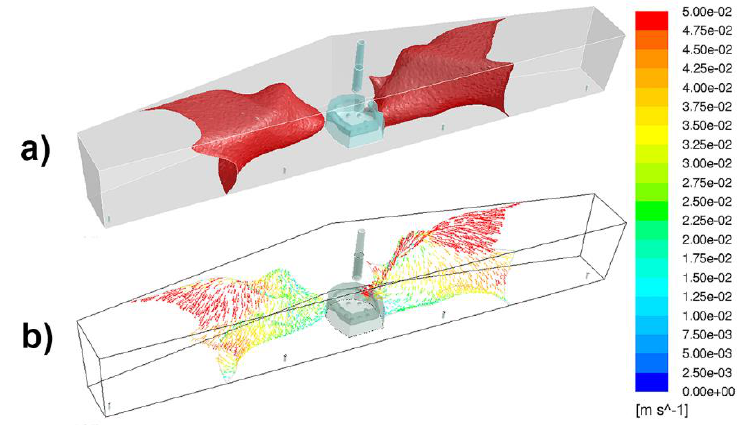
Figure 13. Tracer mixing kinetics for TI3: ( a ) Isoconcentration surface in mass fraction of a tracer 300 s after its injection in the ladle shroud and ( b ) associated velocity field. Isoconcentration surface in mass fraction is 2.6 × 10 −5 .